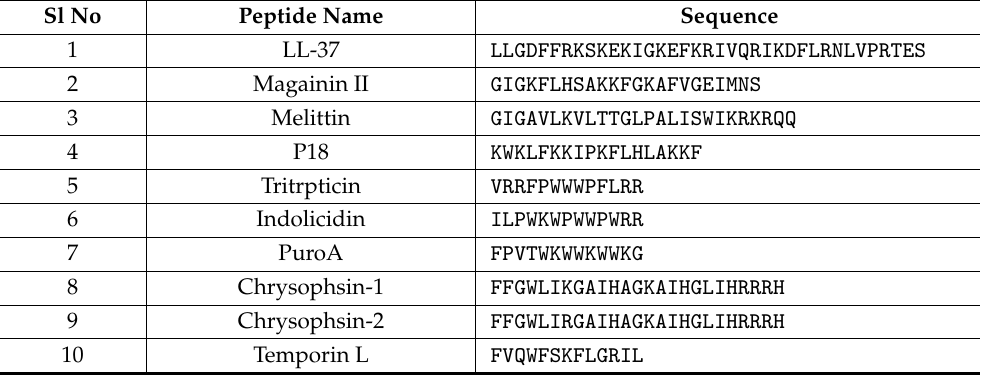
Table 1. Peptide and the amino acid sequences discussed in the Review.